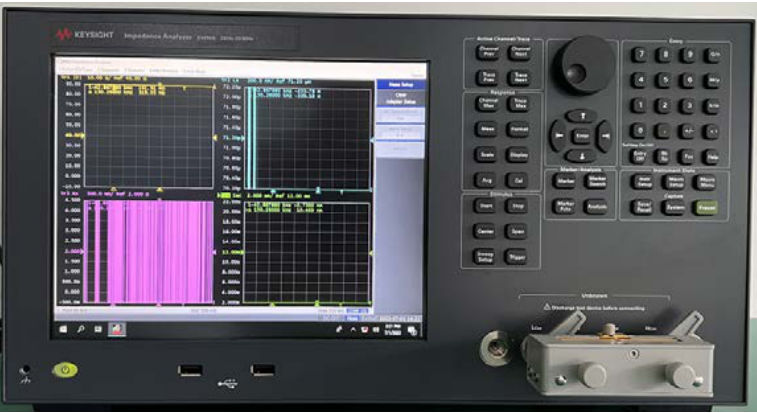
Figure 4. Keysight E4990A Impedance Analyzer.